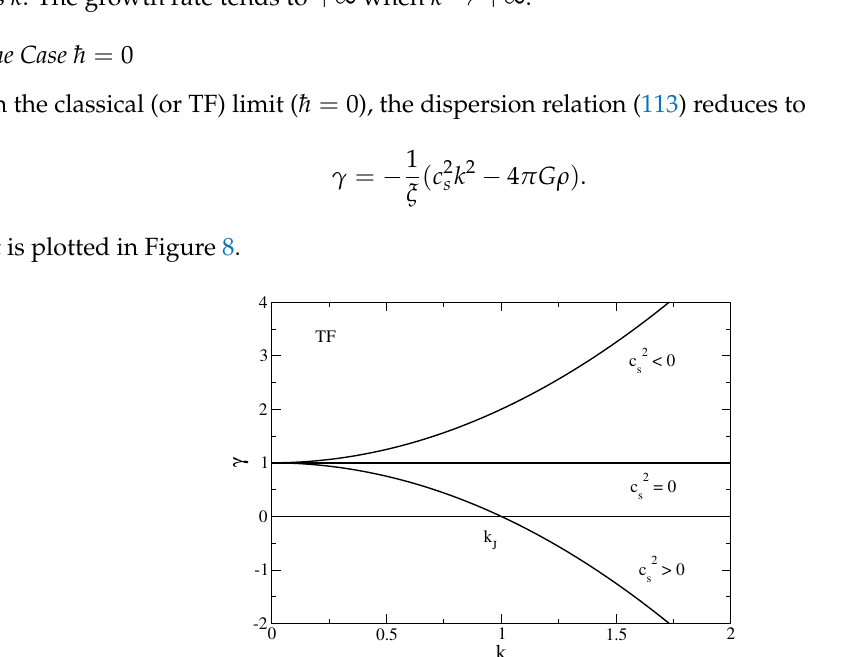
Figure 8. Exponential rate γ for overdamped self-gravitating BECs in the TF limit (¯ h = 0). We have normalized the wavenumber by ( 4 π G ρ / | c 2 s | ) 1/2 and the rate by 4 π G ρ / ξ . This is equivalent to taking 4 π G = ρ = | c 2 s | = ξ = 1 in the dimensional